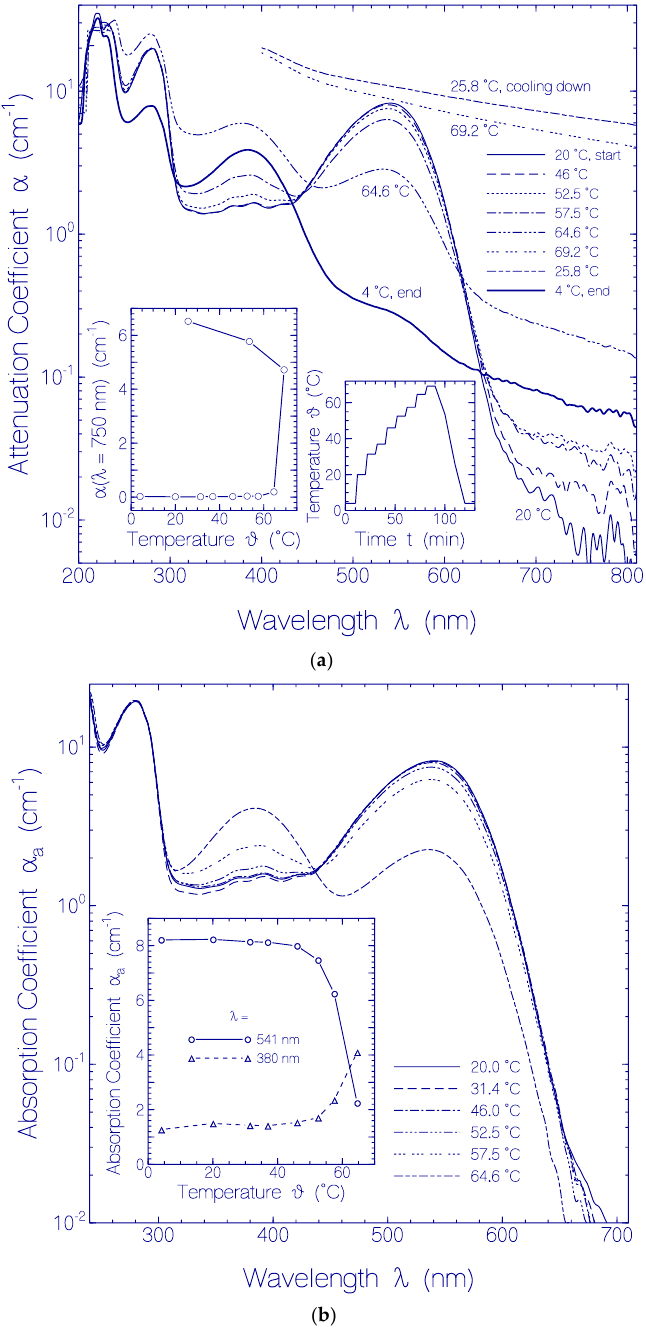
Figure 4. ( a ) Heating-cooling cycle behavior of a fresh thawed CaRh sample in pH 7.3 HEPES/MOPS buffer. Main figure: Attenuation coefficient spectra α ( λ ) development during stepwise sample heating up and cooling down. Right inset: Applied heating and cooling temperature profile ϑ ( t ). Left inset: Temperature dependent attenuation coefficient α ( λ = 750 nm) development; ( b ) Absorption coefficient development of CaRh in pH 7.3 HEPES/MOPS buffer during sample heating up (data from Figure 4a deprived from scattering contribution). Inset: Temperature dependent absorption coefficient development at λ = 541 and 380